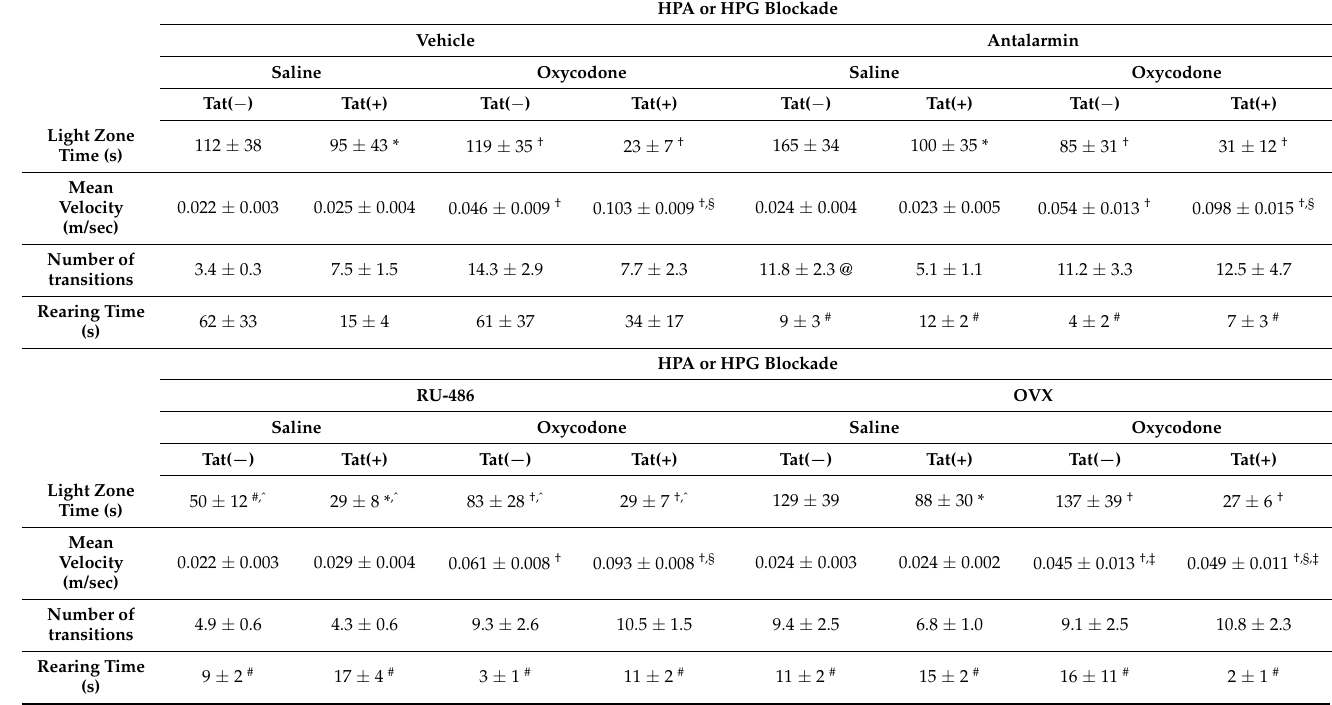
Table 3. Motor and anxiety-like measures for Tat( − ) and Tat(+) female mice assessed in open field and light-dark transition tests. Proestrus mice were pretreated with vehicle, antalarmin, RU-486 or were ovariectomized (OVX) prior to administration of saline or oxycodone. * indicates a main effect of genotype wherein Tat(+) mice differ from Tat( − ) controls. † indicates a main effect of drug condition wherein oxycodone-administered mice differ from saline-administered controls. # indicates a main effect for any HPA or HPG manipulation to differ from vehicle-pretreated mice. ˆ indicates a main effect for RU-486 to differ from antalarmin or OVX. § indicates an interaction wherein oxycodone-administered Tat(+) mice differ from respective Tat( − ) and saline-administered controls. @ indicates an interaction wherein antalarmin treated Tat( − ) mice differ from respective Tat(+) mice and vehicle-treated Tat( − ) controls. ‡ indicates an interaction wherein oxycodone-administered OVX mice differ from oxycodone-administered mice pretreated with vehicle, RU-486 and Antalarmin, p <